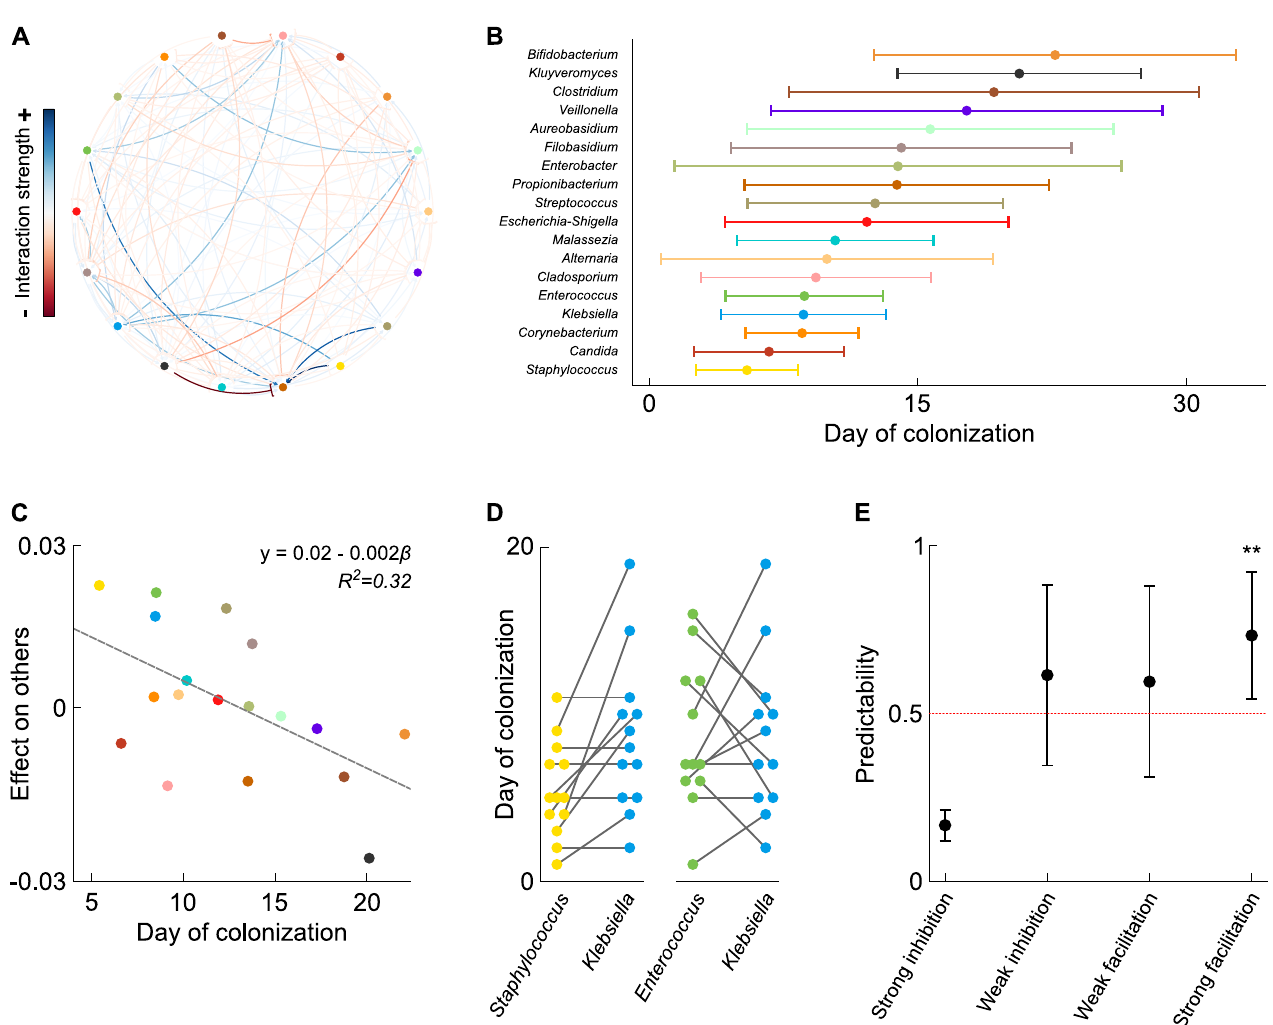
Fig 4. Published data reveal predictable assembly dynamics within the preterm infant gut, driven by interspecies dependencies. (A) Fitting data from 13 preterm infants sampled on a near daily basis for their first 6 weeks of life to the generalized Lotka–Volterra equations reveals a rich network of microbe– microbe interactions playing a strong and consistent role in shaping microbiome dynamics. ( B) The preterm gut assembles in a robust and predictable manner, with specific taxa colonizing at different points in time. ( C) More helpful taxa, determined by average effect on others, tend to colonize earlier in infant life ( R 2 = 0 . 32 , p = 0 . 02 ). ( D) We quantify the predictability of individual pairs of genera by calculating the proportion of infants in which the focal genus only colonizes with or after the partner genus. ( E) Genus pairs in which the focal taxon receives a strong benefit from its partner (interaction α ij > 0.1) display predictable assembly dynamics, with the focal taxon significantly more likely to only colonize with or after its partner than expected by chance (average predictability score 0.73 > 0.5, one-sample permutation test p = 0.002). Underlying data in S4 Data.